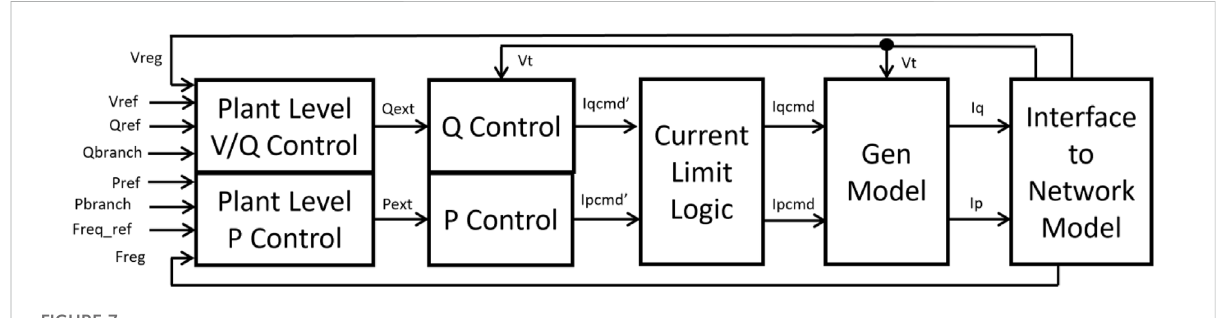
FIGURE 7 Modular representation of System Generation Generic Model.